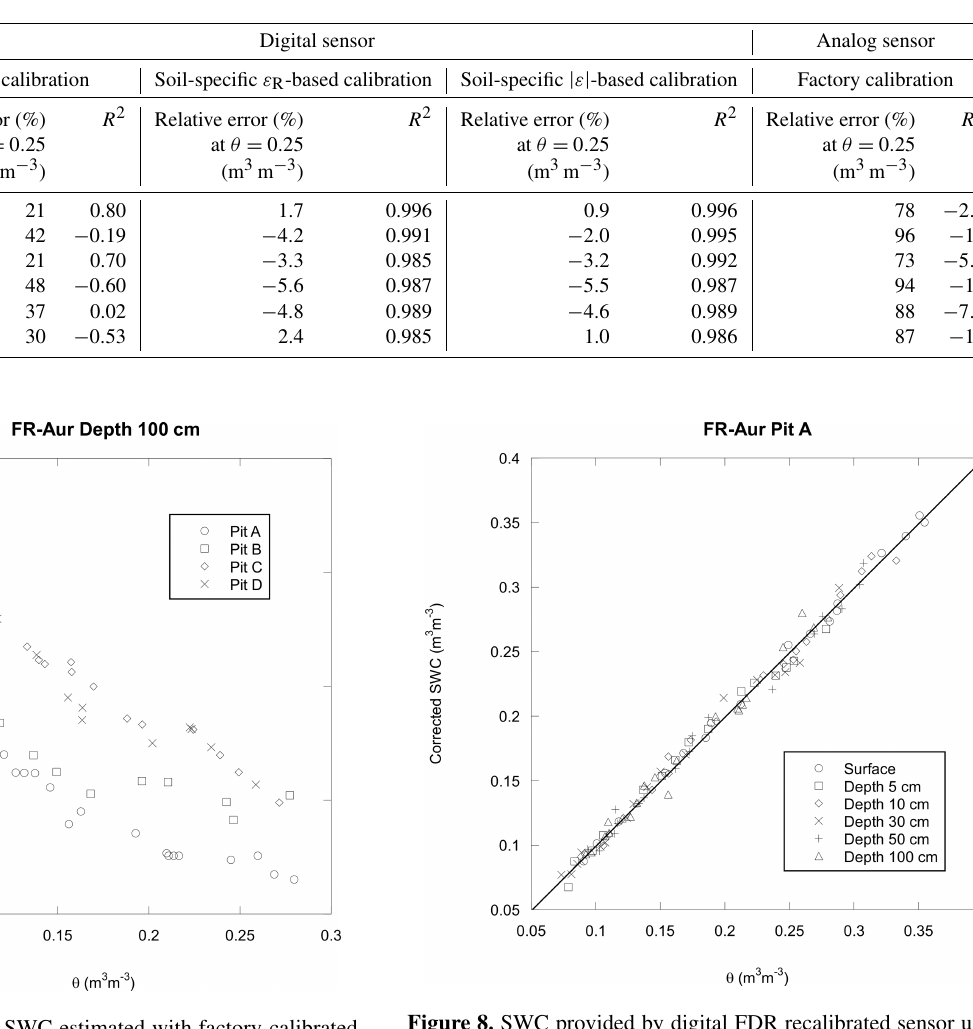
Figure 7. Relative error in SWC estimated with factory-calibrated digital sensor versus real SWC for depth of 100cm inside all four pits.